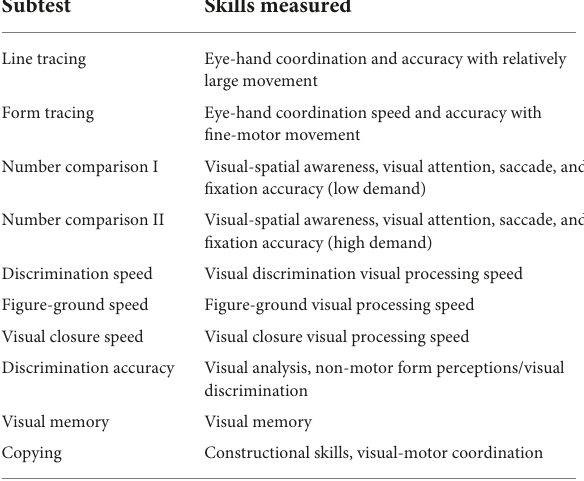
TABLE 1 Skills measured by the WAVES subtests (Okumura et al.,